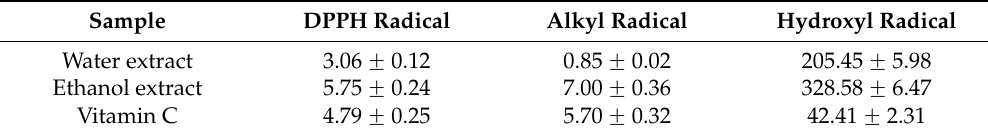
Table 2. Various radical scavenging activities of CSL extract (IC 50 , µ g/mL).